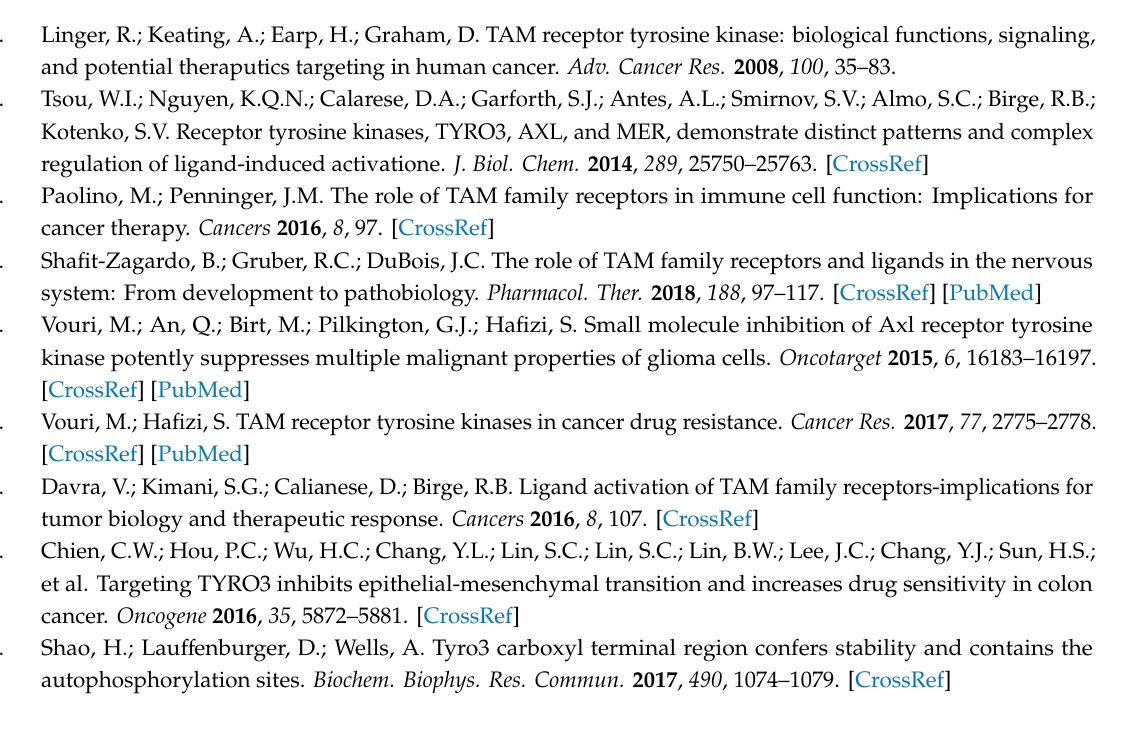
Figure S1: E ff ect of ProS1 and Gas6 stimulation on Tyro3 phosphorylation and signalling in six human cancer cell lines; Figure S2. E ff ect of ProS1 and Gas6 stimulation on Axl phosphorylation and signalling in three human cancer cell lines; Figure S3. Representative dot plot diagrams obtained by flow cytometry with Annexin V-FITC / PI double-staining of SCC-25 (A) and MGH-U3 (B) cells; Figure S4. Confirmation that staurosporine does not inhibit Tyro3 kinase activity and its activation by TAM ligands; Figure S5. MTS cell viability assay showing the anti-apoptotic influence e ff ects of ProS1 and Gas6 to also occur when apoptosis is induced by an alternative agent, cisplatin; Figure S6. MTS cell viability assay showing that blockade of Erk signalling prevents the anti-apoptotic e ff ect of ProS1; Figure S7. Verification of changes in levels of phosphorylated Erk (pErk) and Akt (pAkt) proteins in relation to total Erk and Akt protein levels in western blots; Table S1. Ten human cancer cell lines were analysed for expression of the TAM receptors and their ligands Gas6 and ProS1; Table S2: Primers used in qRT-PCR; Whole blot